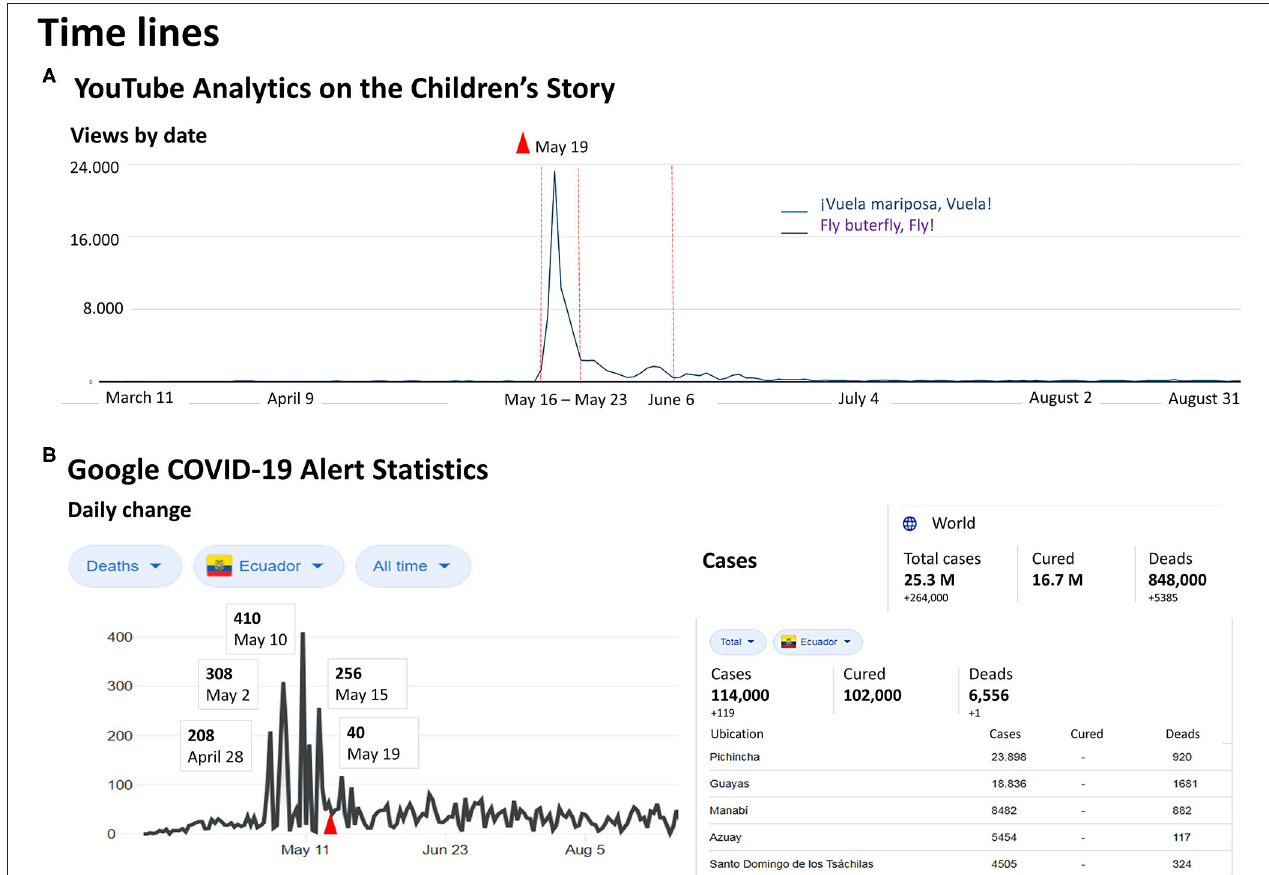
FIGURE 1 | Time lines. ( A) Temporal map of ’1Vuela mariposa, Vuela! video’s virality provided by YouTube analytics and views per day of the English version. (B) Synchronicity of the children’s story virality (red icon) shown with Google COVID-19 alert statistics for Ecuador during the same period, March 11 and August 31, 2020. Right table: Total cases, cured and deads in the world, Ecuador and different Ecuadorian areas are